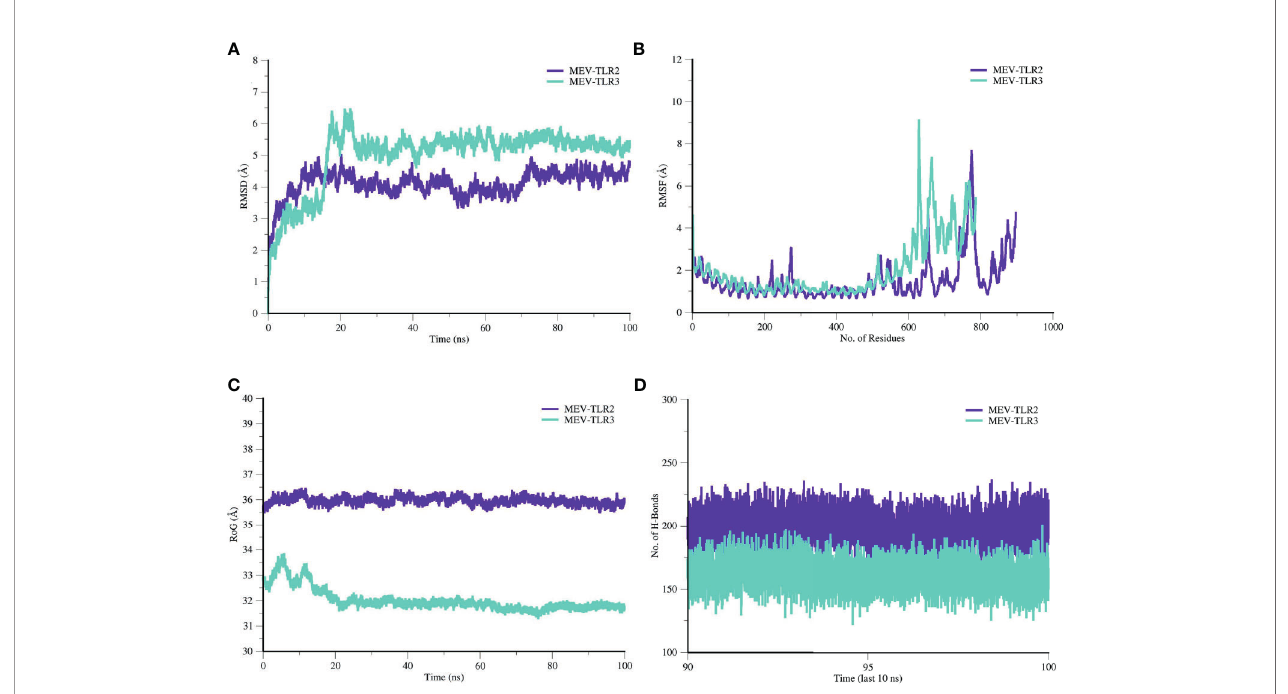
FIGURE 7 | Molecular dynamics simulation analysis of MEV and TLR receptors. (A) RMSD, (B) RMSF, (C) RoG and (D) Hydrogen bond